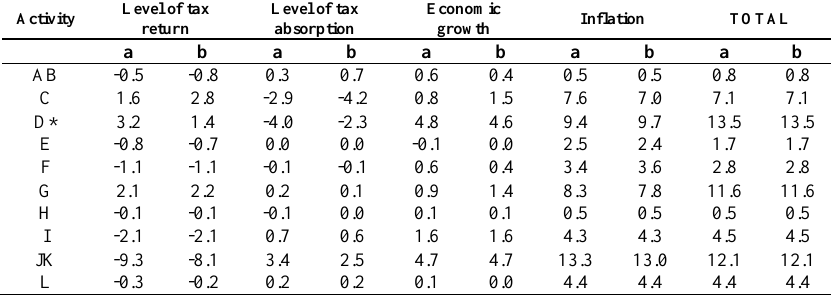
Table 2. The contribution of activities and their factors to the growth of tax revenue in the sub-federal budgets in 2011–2015 compared to 2006–2010 (%) Level of tax Activity